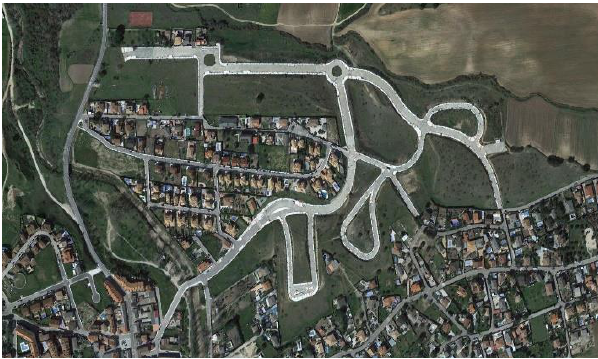
Figure 18. Quijorna. Madrid,Spain after 2007